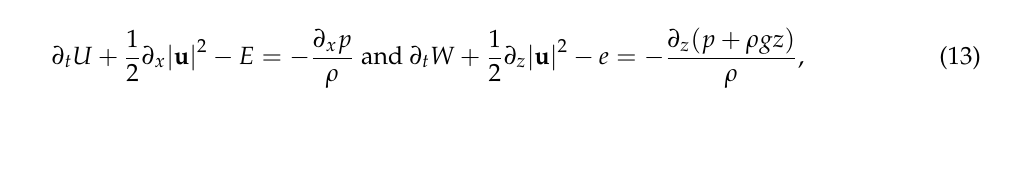
Figure 1. Waves propagating in variable bathymetry in the presence of current with velocity